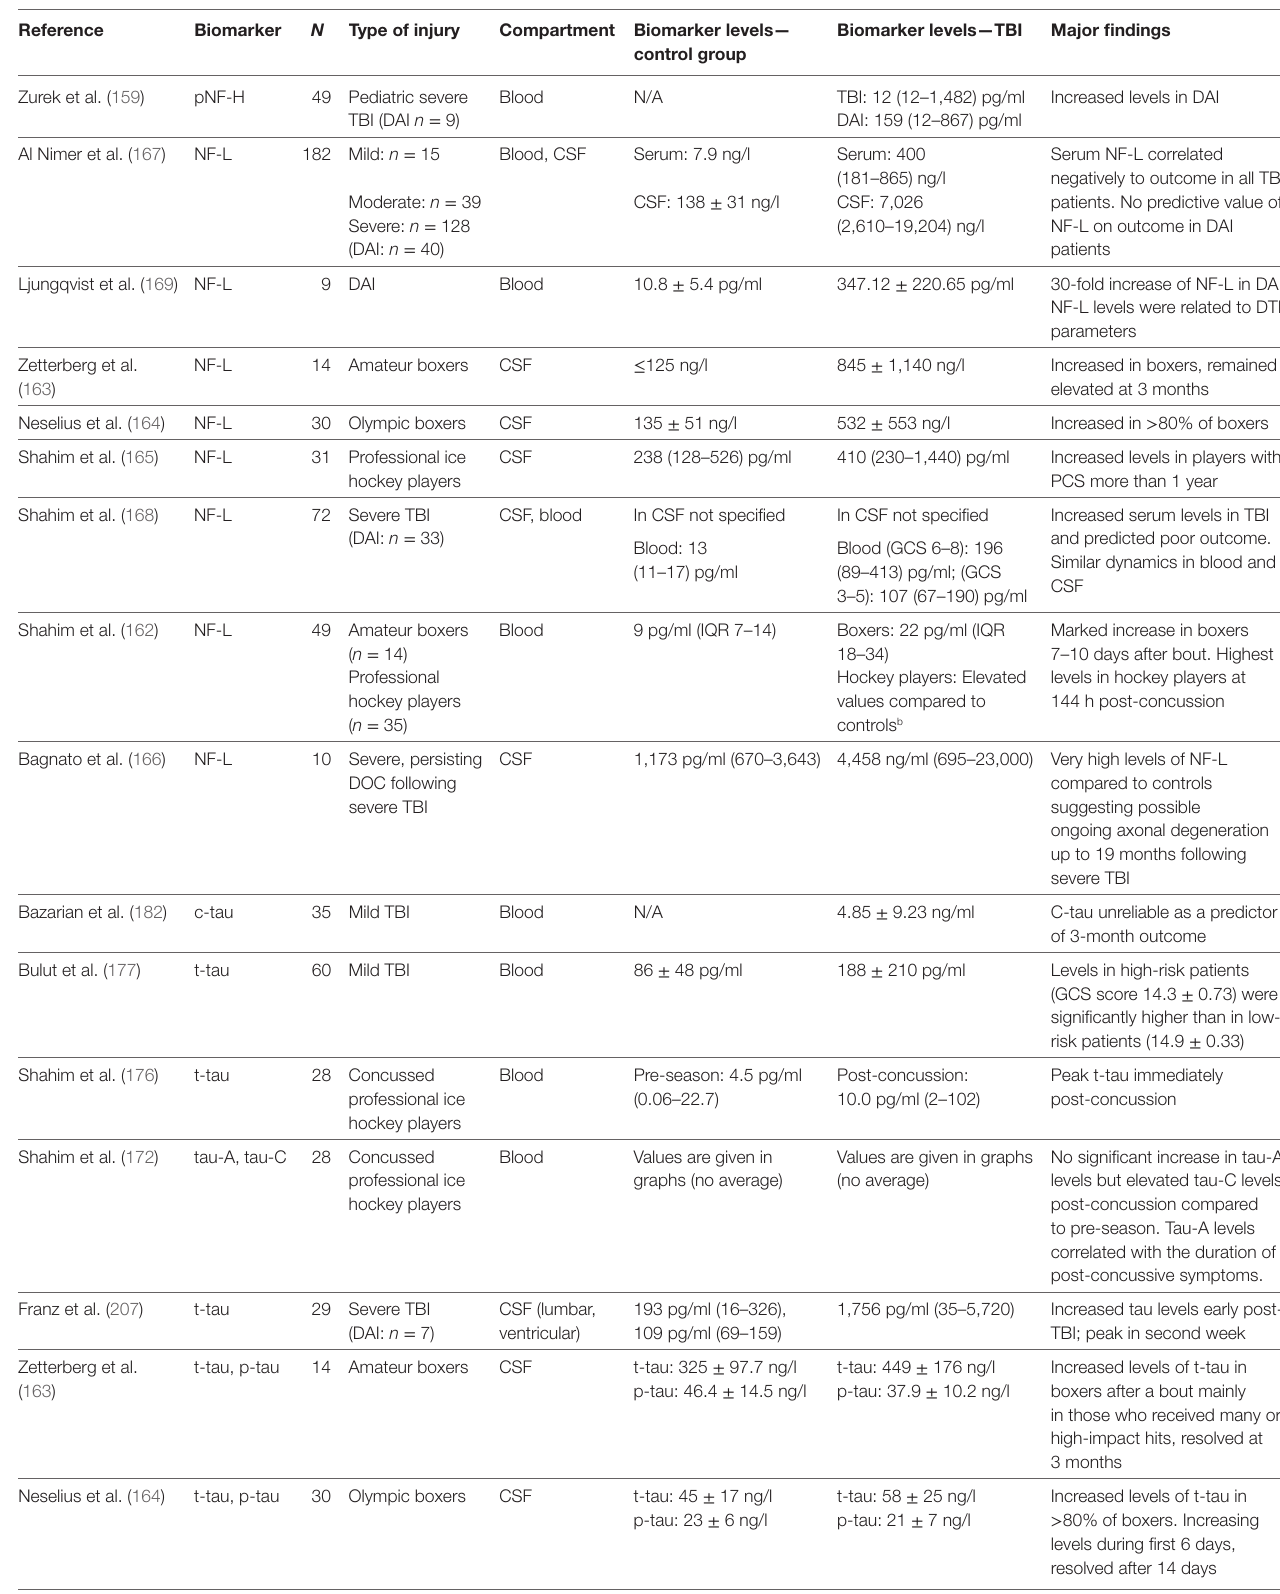
TABLe 1 | Blood and cerebrospinal fluid (CSF) levels of common axonal injury biomarkers (neurofilament, tau, SBDP and amyloid- β ) in clinical